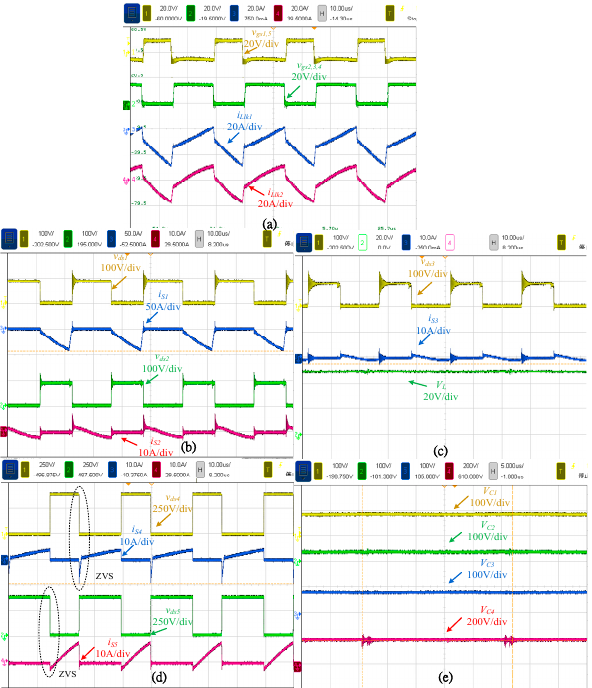
Figure 13. Experimental results obtained when operating the proposed converter at full load and a V H value of 400 V in the step-down mode: ( a ) waveforms of v gs1,5 , v gs2,3,4 , i Llk1 , and i Llk2 ; ( b ) waveforms of the v ds and i s values of S 1 and S 2 ; ( c ) waveforms of the v ds and i s values of S 3 and of the output voltage; ( d ) waveforms of the v ds and i s values of S 4 and S 5 ; and ( e ) waveforms of the voltages of C 1 , C 2 , C 3 , and C 4 .